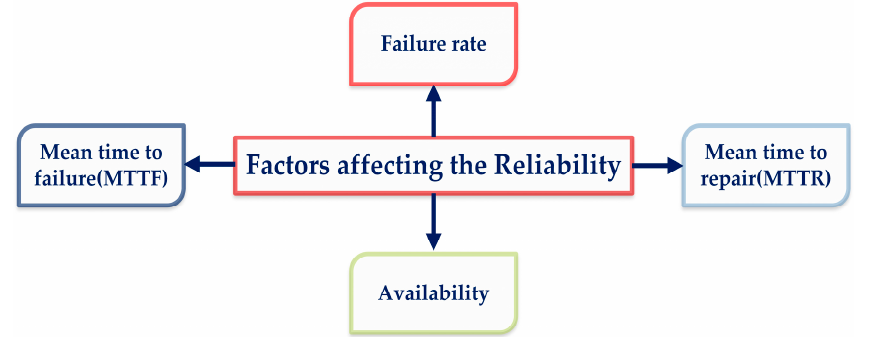
Figure 15. Di ff erent factors a ff ecting the reliability.